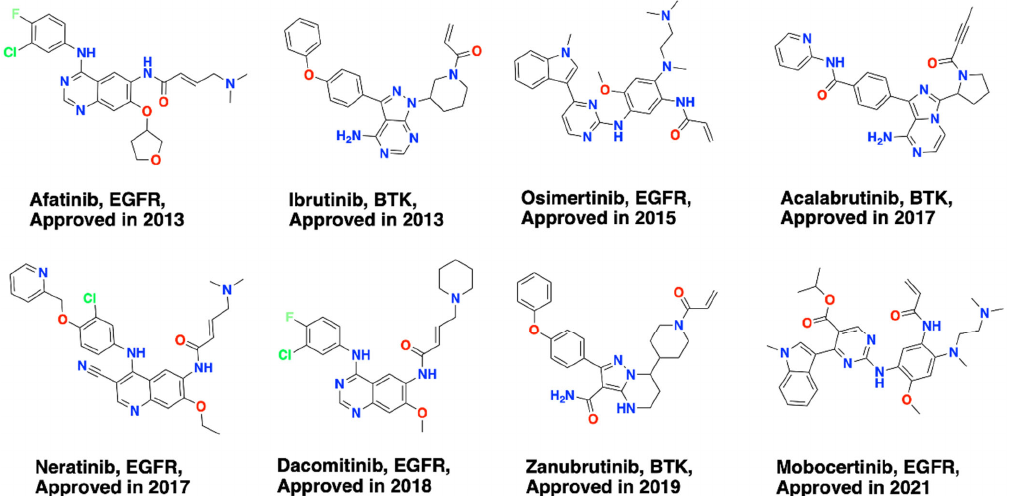
Figure 1. FDA ‐ approved covalent kinase inhibitors with year approved and primary target. Figure 1. FDA-approved covalent kinase inhibitors with year approved and primary target.